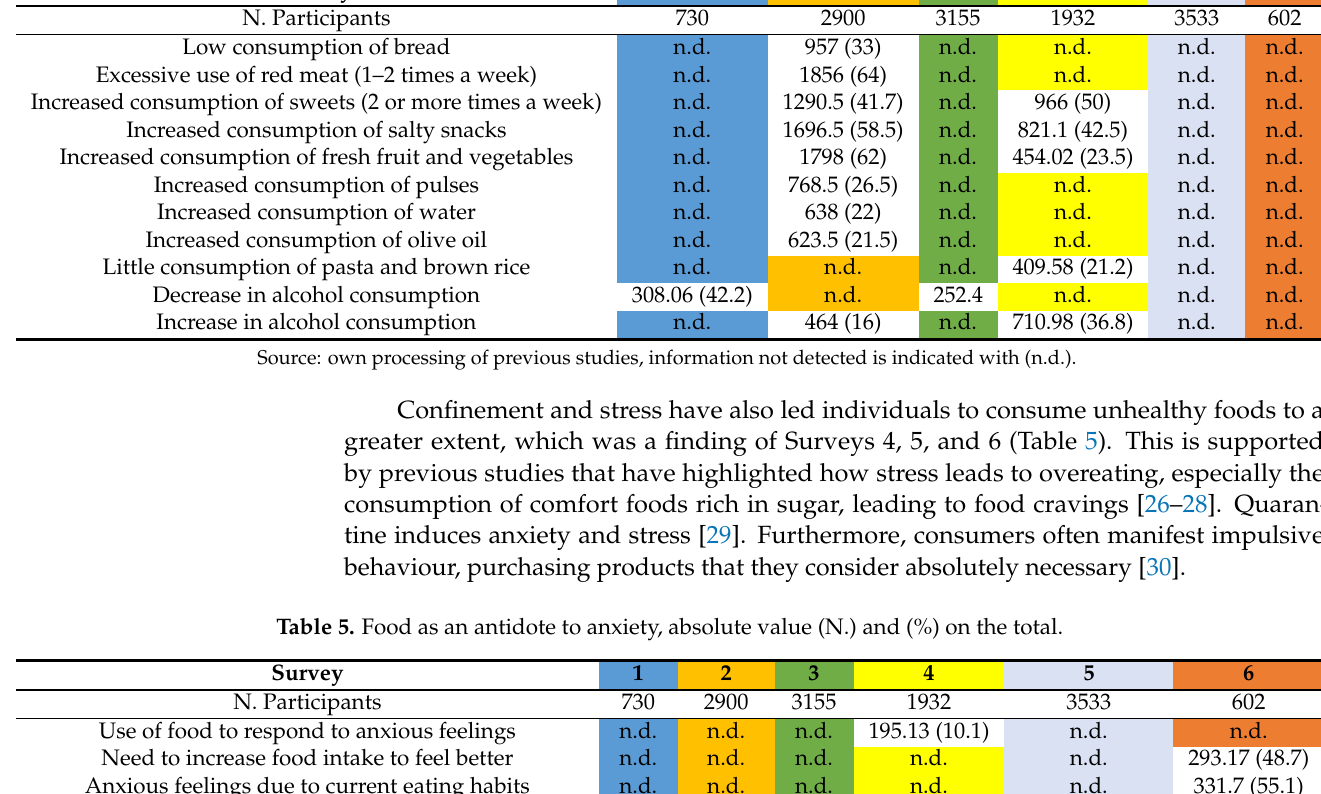
Table 4. Changes in the shopping basket, absolute value (N.) and (%) on the total. Survey